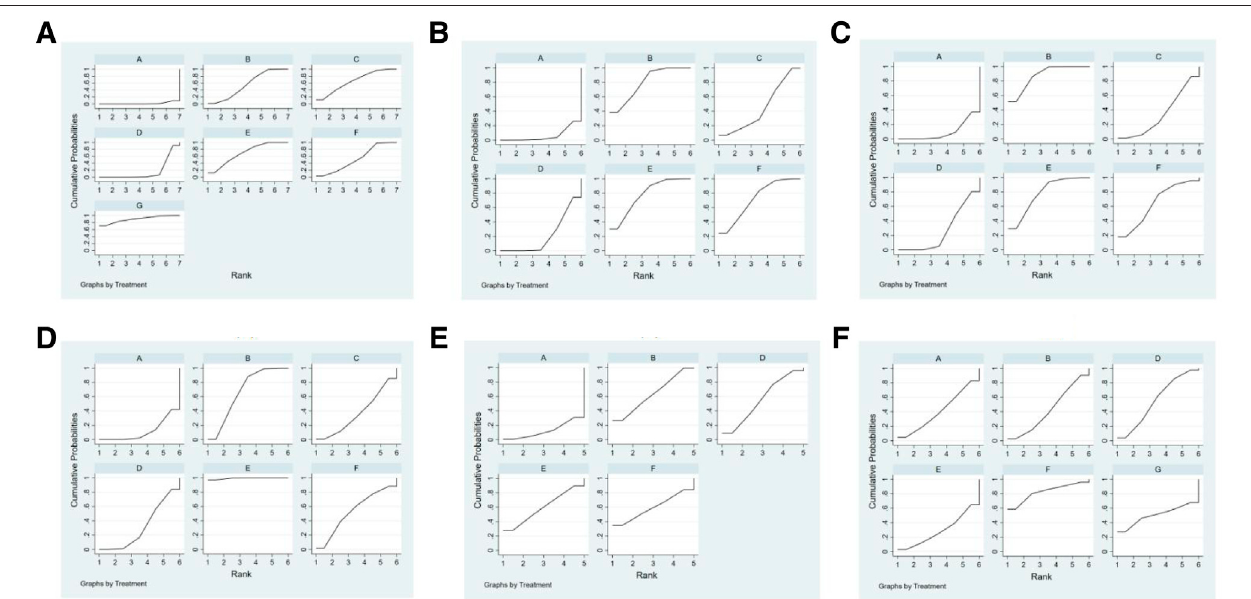
FIGURE6| SUCRAofoutcome indicators. (A) :effectiveness rate; (B) :CK; (C) :CK-MB; (D) :LDH; (E) :cTnI; (F) :adversereaction rate.A:conventional treatment; B: conventional treatment + trimetazidine + Astragalus injection; C: conventional treatment + trimetazidine + Shenfu injection; D: conventional treatment + trimetazidine; E: conventional treatment + trimetazidine + Salviae miltiorrhizae and ligustrazine hydrochloride injection; F: conventional treatment + trimetazidine + Breviscapine injection; G: conventional + treatment + trimetazidine + Shenmai injection.